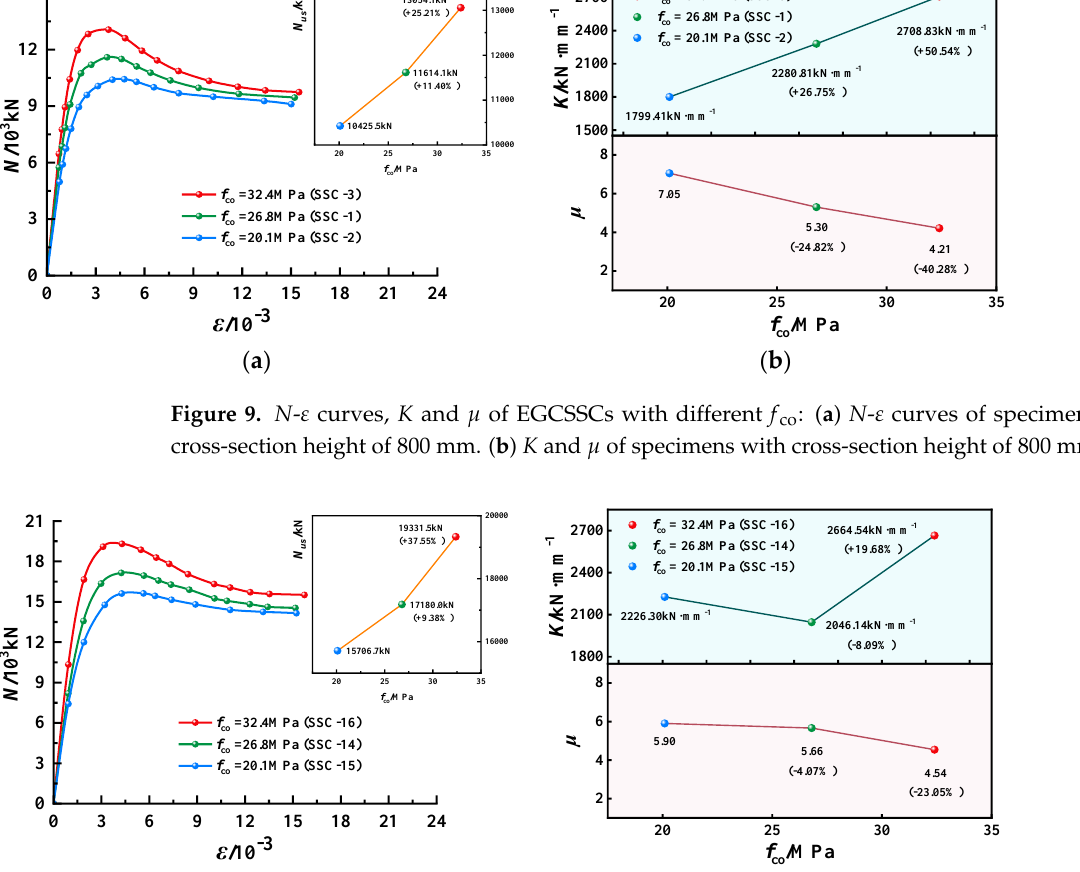
Figure 10. N - ε curves, K and µ of EGCSSCs with different f co : ( a ) N - ε curves of specimens with cross-section height of 1000 mm. ( b ) K and µ of specimens with cross-section height of 1000 mm.